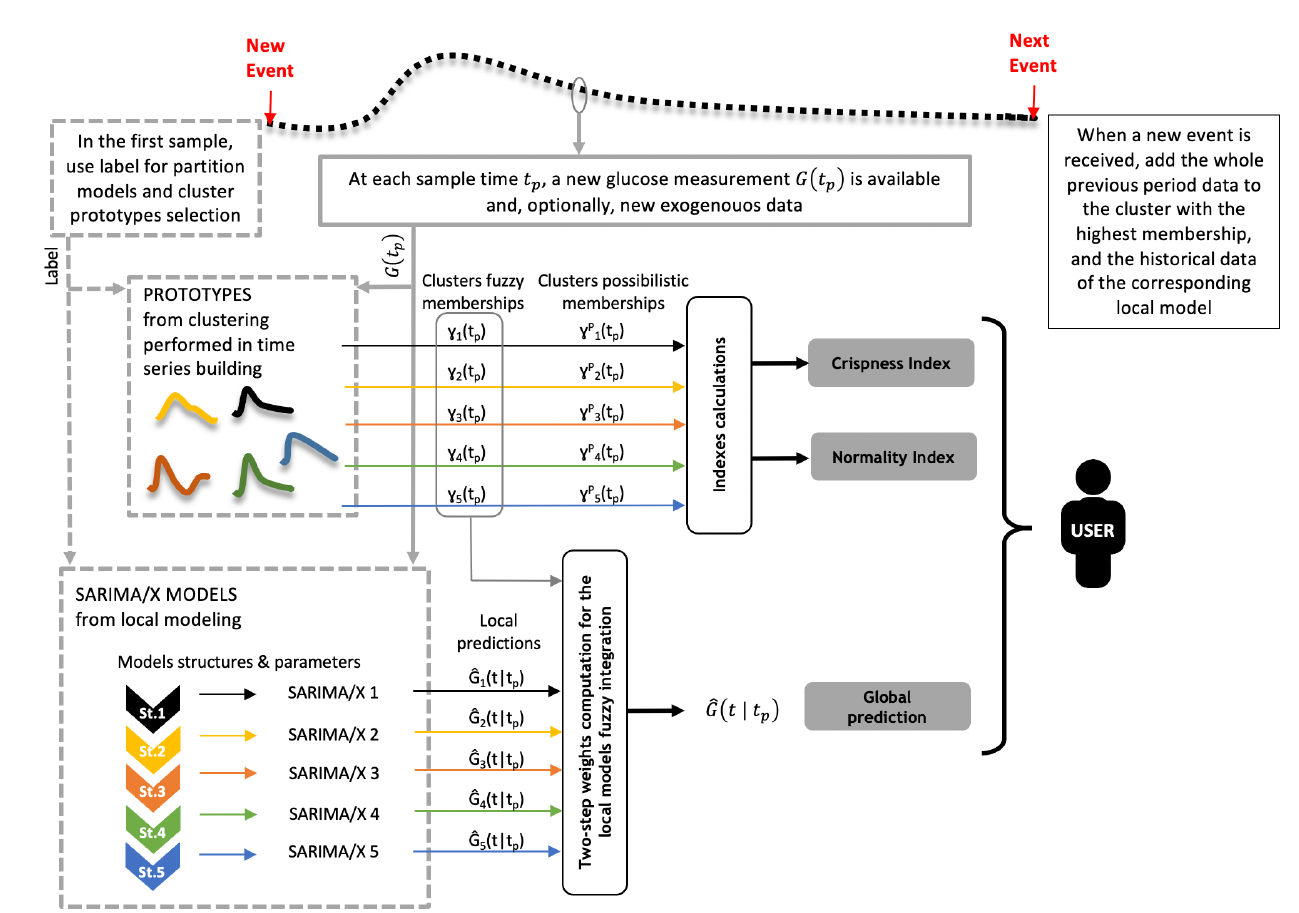
Figure 4. Real-time operation of the glucose predictor. When a new event is reported, the predictor trained for that event class (meal, night, or hypo treatment in this work) is selected. This predictor will be composed of a number of cluster prototypes and local models (dashed boxes PROTOTYPES and SARIMA/X MODELS). Then, at each sampling time t p , a new glucose measurement G ( t p ) is received from the CGM, and a predicted trajectory ˆ G ( t | t p ) is computed considering a given prediction horizon. To this end, fuzzy memberships to each cluster, γ i ( t p ) , provide the weighting factors of predicted trajectories by the local models, ˆ G i ( t | t p ) , following the two-step method described in Section 2.5. Additionally, crispness and normality indices are computed from fuzzy and possibilistic memberships to each cluster, respectively, as described in this section, which are provided as outputs together with the predicted trajectory. When the next event happens, the CGM time series of the last period is added to the cluster with most similar prototype, as well as to the historical data of the local model associated to that